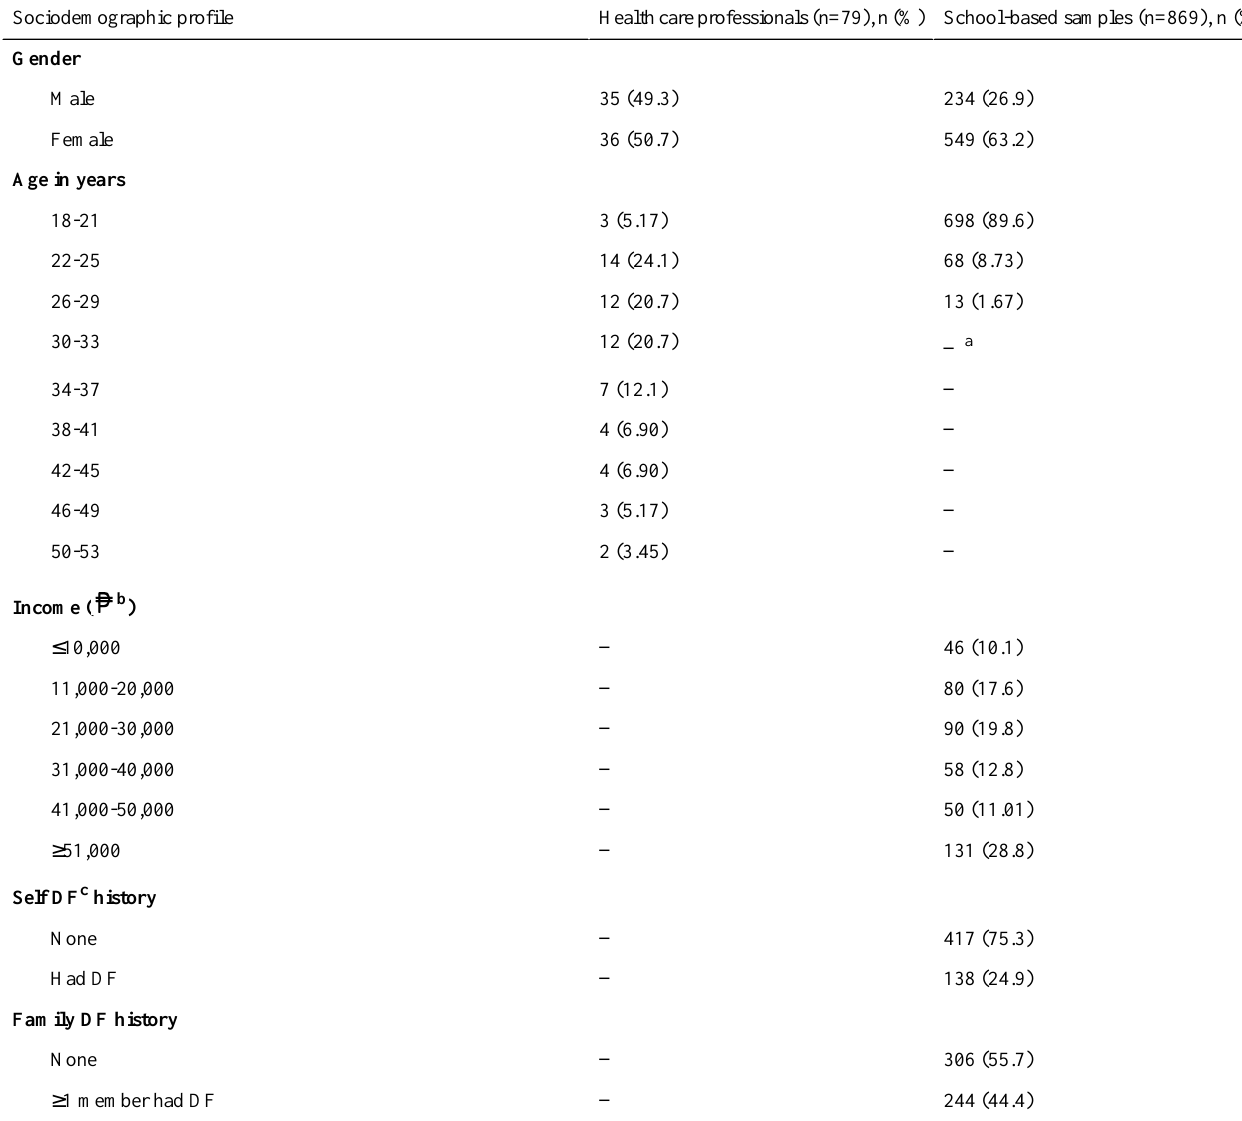
Table 1. Sociodemographic and dengue fever history profile of health care professionals and school-based